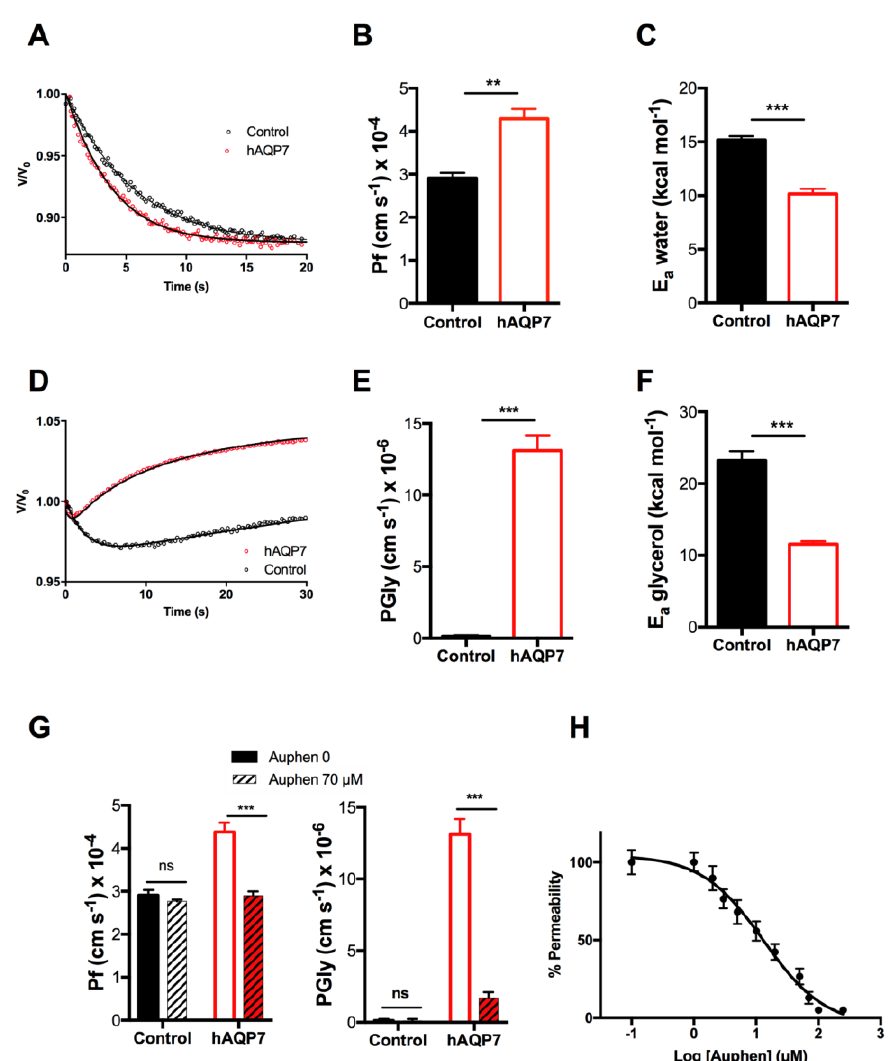
Figure 1. Water and glycerol permeability in control and cells expressing hAQP7. ( A ) Representative time course of the relative cell volume ( V / V 0 ) changes after a sorbitol hyperosmotic shock (pH 7.4, 23 ◦ C) inducing water efflux and cell shrinkage. ( B ) Water permeability coefficient ( P f ) and ( C ) activation energy ( E a ) for water permeation. ( D ) Representative time course of the relative cell volume ( V / V 0 ) change after a glycerol hyperosmotic shock (pH 7.4). After the fast water outflow, glycerol influx induces cell reswelling. ( E ) Glycerol permeability ( P Gly ) and ( F ) activation energy ( E a ) for glycerol permeation. ( G ) Water and glycerol permeability of cells upon treatment with Auphen (30 min, 70 µ mol/L). ( H ) Dose-response curve of glycerol permeability inhibition by Auphen, IC 50 = 12.95 ± 0.35 µ mol/L. All permeability assays were performed at 23 ◦ C, except for E a assessment. Data are shown as mean ± SEM of five independent experiments. ns, non-significant; ** p < 0.01; *** p <